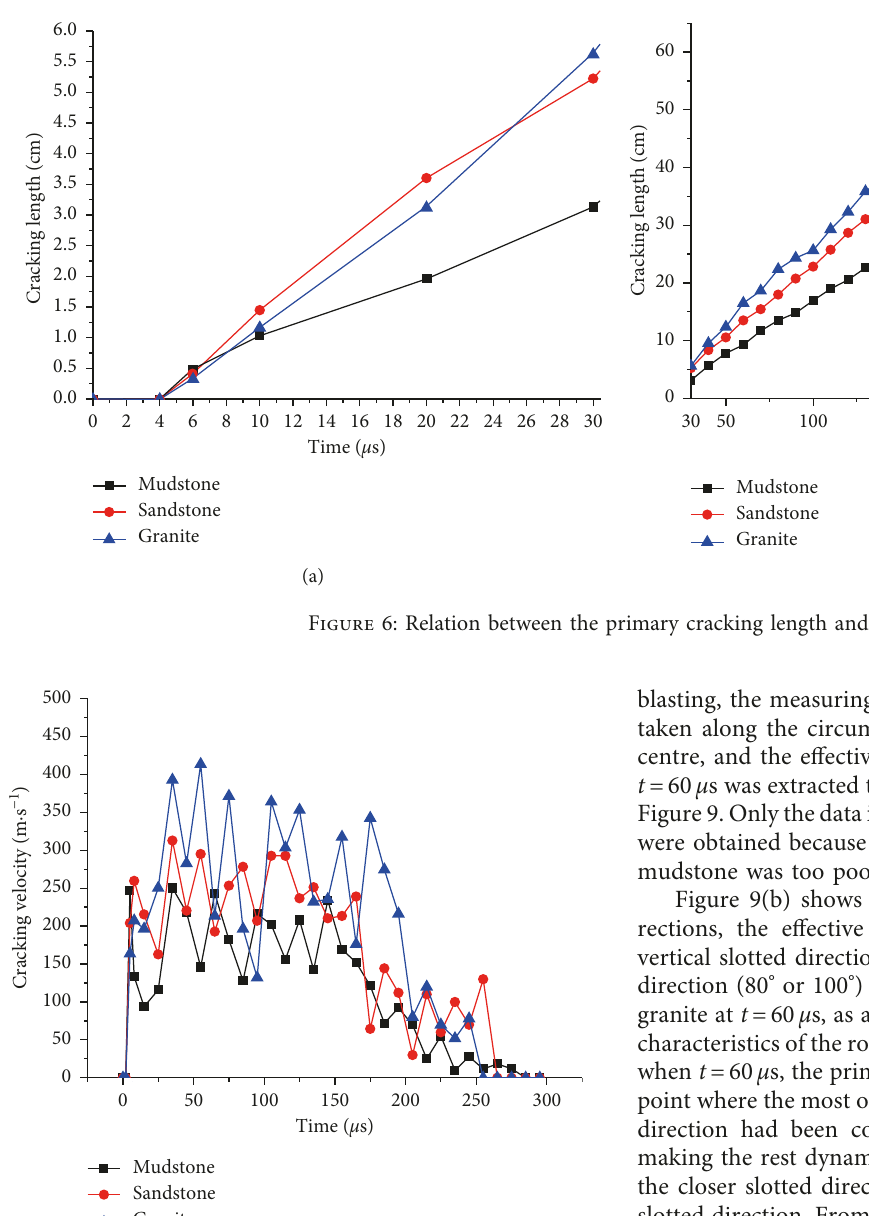
Figure 7: Relation between the primary cracking velocity and